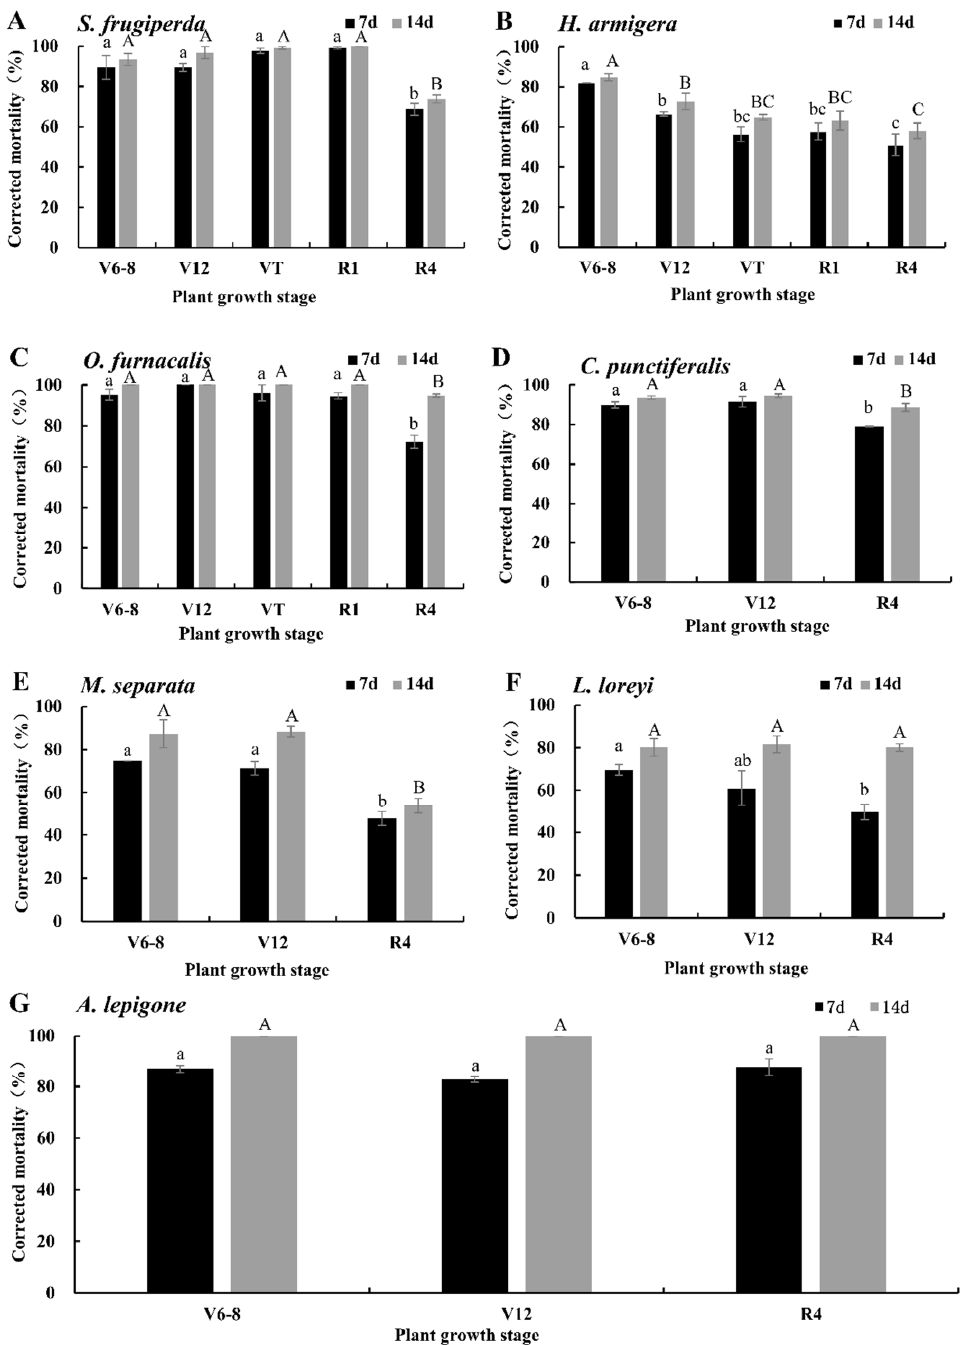
Figure 1. Corrected mortalities of neonates for seven lepidopteran pests on artificial diet containing lyophilized different tissues of DBN9936 corn (expressing Cry1Ab) in different growth stages at a 25-fold dilution relative to the isogenic negative control. Values represent means ± SE. Different lowercase and uppercase letters above black and gray bars indicate significant difference for the same treatment time by Duncan’s multiple range test ( p < 0.05). ( A ) S. frugiperda ; ( B ) H. armigera ; ( C ) O. furnacalis ; ( D ) C. punctiferalis ; ( E ) M. separata ; ( F ) L. loreyi ; and ( G ) A. lepigone.